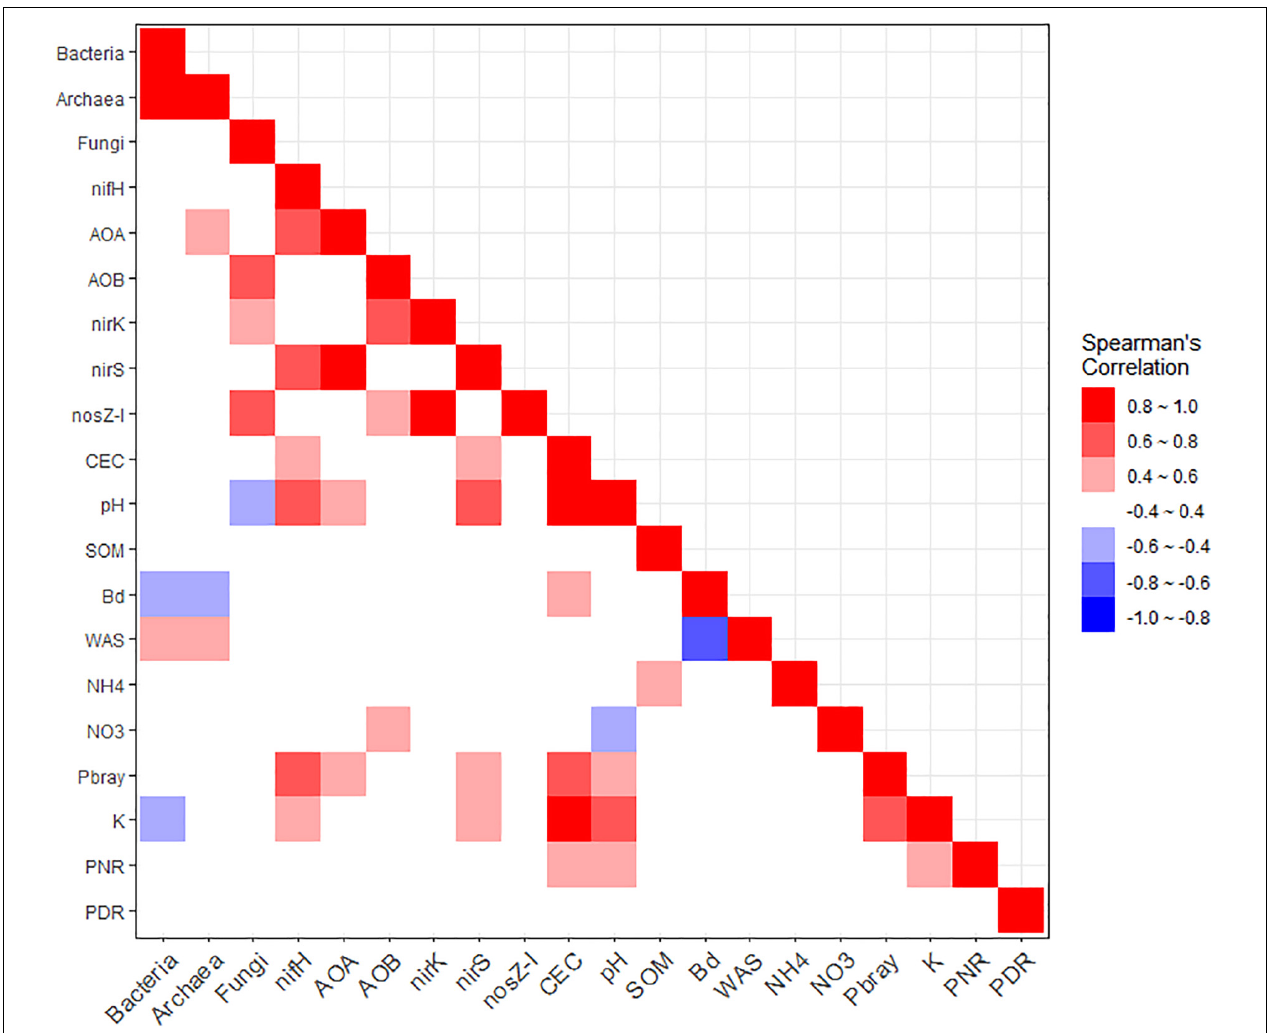
FIGURE 5 | Heatmap depicting the matrix of Spearman’s rank correlation coefficients among the soil microbial marker genes, soil properties, and potential nitrification (PNR) and denitrification (PDR) rates. Marker genes included bacterial (Bacteria) and archaeal (Archaea) 16S rRNA, fungal ITS region (Fungi), nifH , archaeal (AOA) and bacterial (AOB) amoA , nirK , nirS , and nosZ-I . Soil properties included cation exchange capacity (CEC, cmol c /kg), pH, soil organic matter (SOM,%), bulk density (Bd, Mg/m 3 ), water aggregate stability (WAS,%), ammonium (NH 4 , mg/kg), nitrate (NO 3 , mg/kg), available phosphorus (Pbray, mg/kg), and extractable potassium (K, mg/kg). The red and blue hues each indicate positive and negative associations, respectively. Higher color saturation indicates greater absolute values of Spearman’s rank correlation